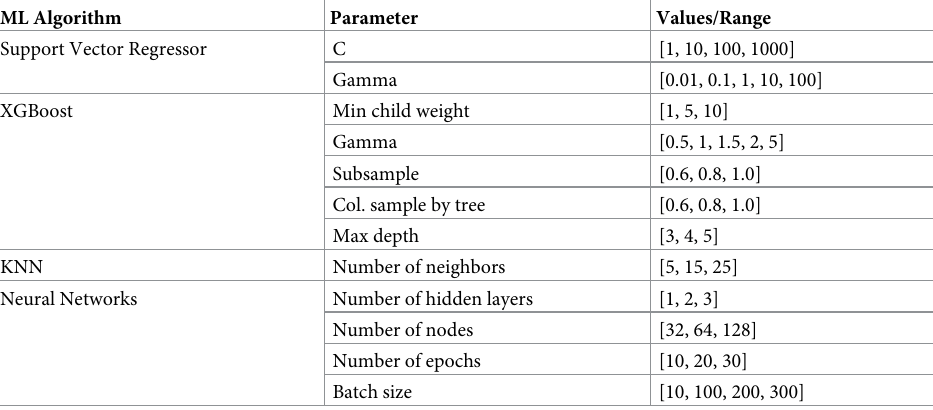
Table 2. Hyperparameter tuning space for each machine learning algorithm.